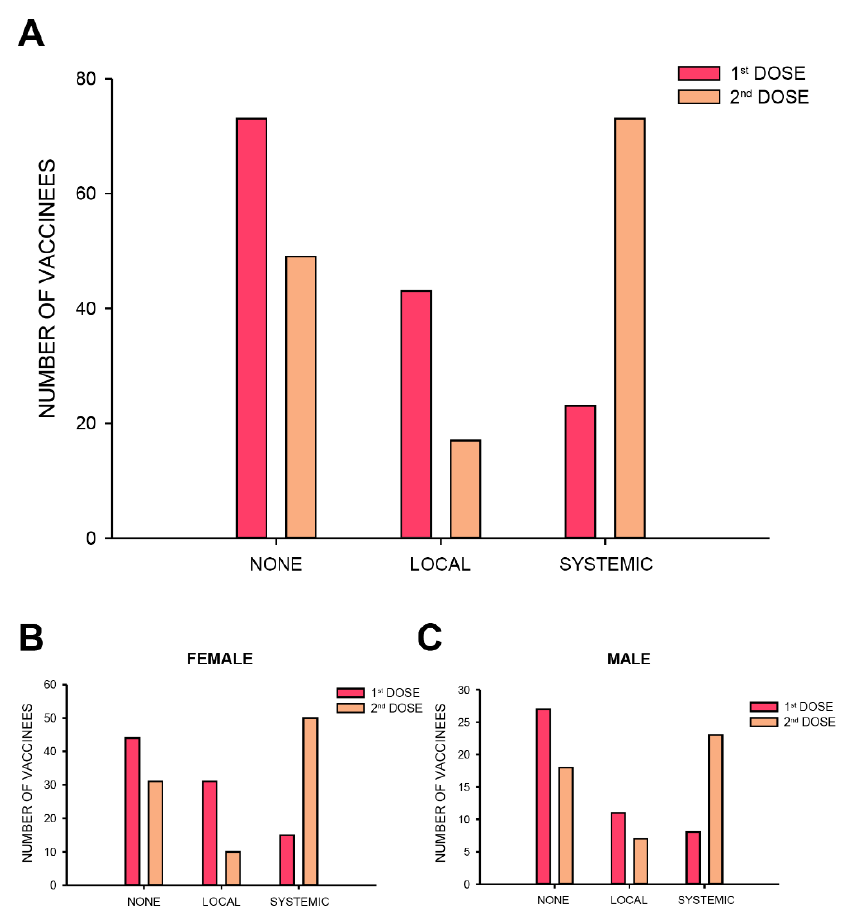
Figure 2. Adverse reactions shift from no/local reactions to systemic following the 2nd vaccine dose. ( A ) The distribution of the various types of reactions- none, local or systemic, following each vaccination dose (Chi-square, p < 0.001). ( B , C ) The majority of adverse reactions following the 2nd vaccine dose were systemic for both females (Chi-square, p < 0.001) and males (Chi-square, p < 0.01). All of the 136 healthcare workers had a positive antibody response, defined as ≥ 50 AU/mL. The median antibody level in the cohort was 8879.5 AU/mL (interquartile range